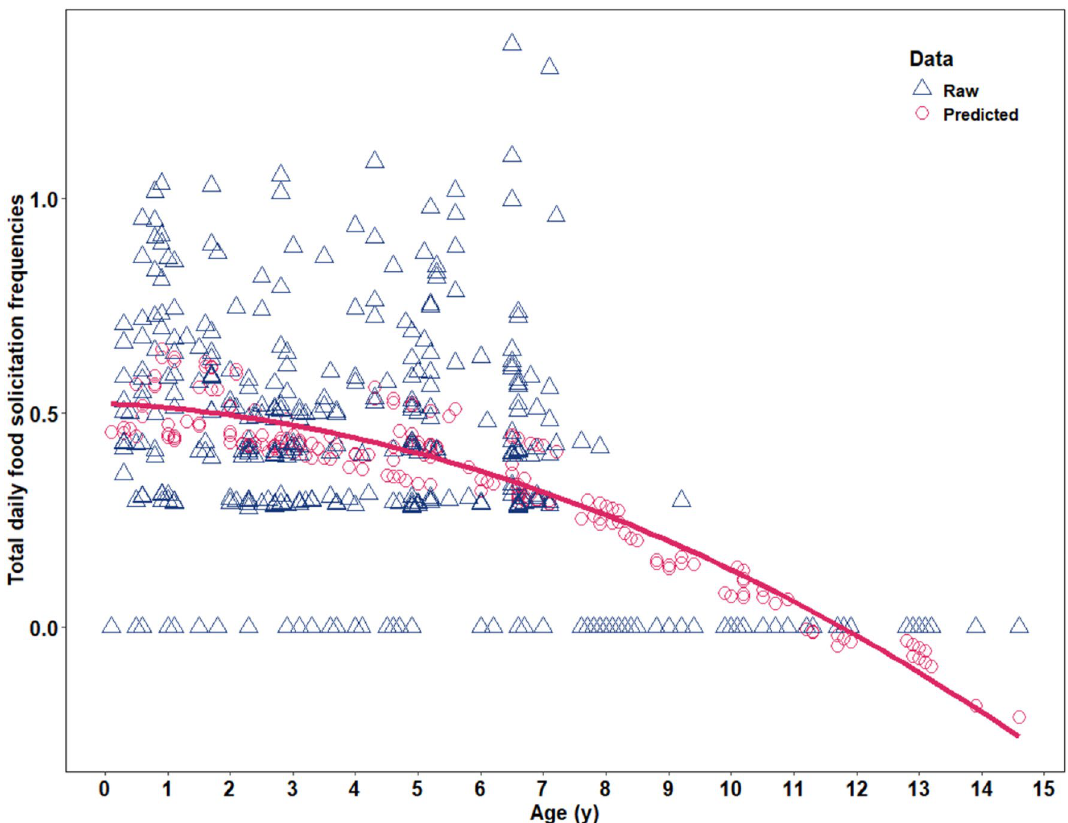
Figure 1. Effect of the offspring’s age (in years) on predicted food solicitation frequencies (square root transformed; model 1 , dataset 1 , N = 416 food solicitation frequencies). The blue triangles represent the raw daily food solicitation frequencies (events per hour). The pink circles are the predicted daily food solicitation frequencies. The pink curve shows the fitted probability at the 95%